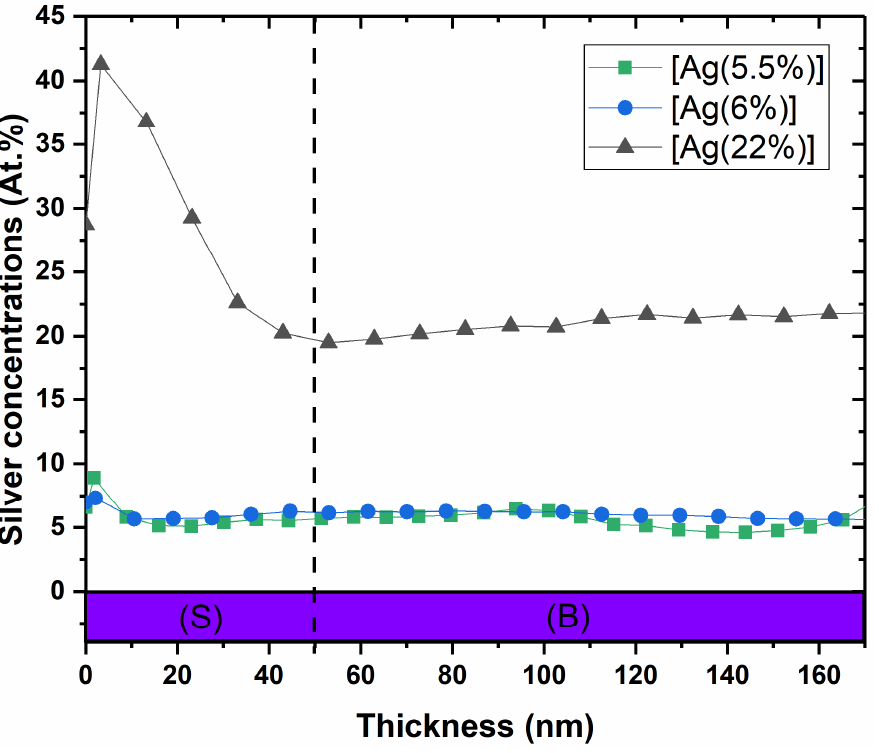
Figure 1. XPS depth profile of [Ag(5.5%)], [Ag(6%)] and [Ag(22%)] showing the atomic percentages (at.%) of silver in the a-C:H matrix containing Ag. (S) = surface ranging from 0 to 50 nm; (B) = bulk.